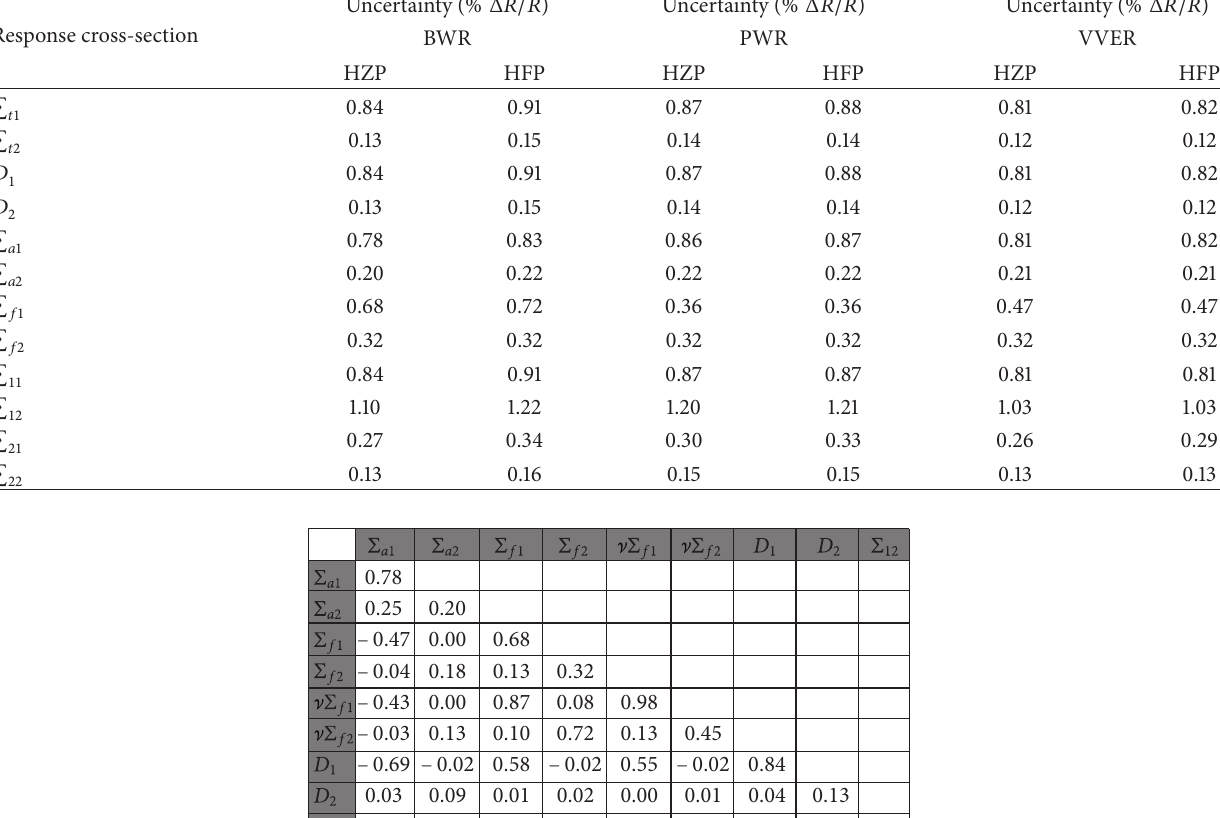
Table 3: Two-group cross-section uncertainty in LWR fuel assembly.